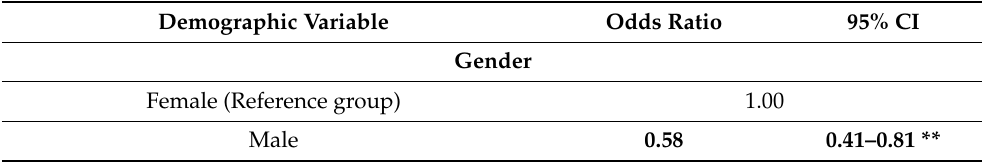
Table 3. Binary logistic regression